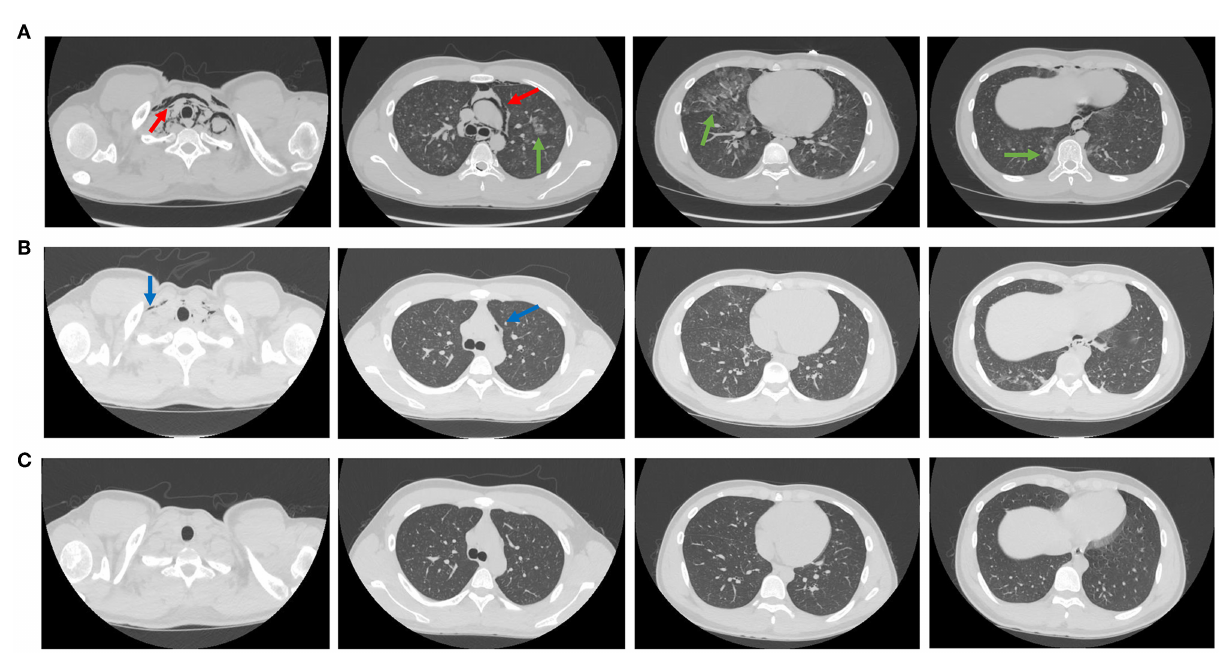
FIGURE1 The manifestations of lungs and mediastinum in computed tomography. The CT manifestations of lungs and mediastinum on 12 November 2022. The injuries indicated by the red arrow were pneumomediastinum, which spreads to the base of the neck. The injuries indicated by the green arrow were mottled and patchy ground glass opacities (A) . The CT manifestations of lungs and mediastinum on 15 November 2022. The injuries indicated by the blue arrow were pneumomediastinum that has improved significantly (B) . The CT manifestations of lungs and mediastinum on 21 November 2022. The pneumomediastinum and ground glass opacities were completely absorbed (C)